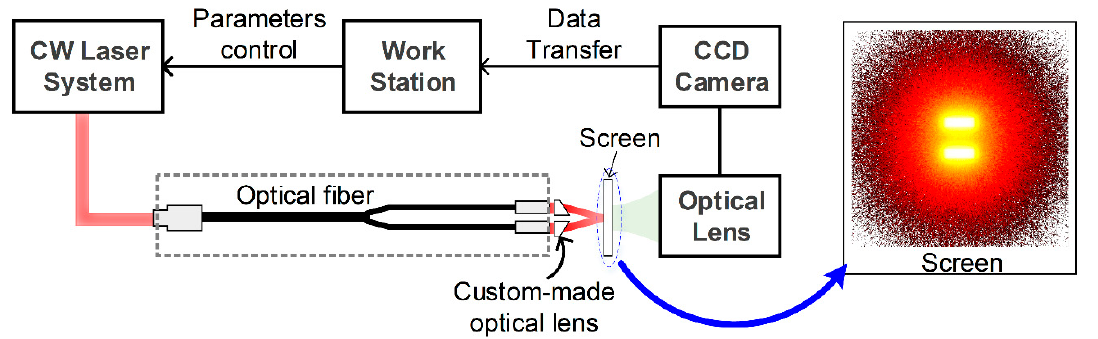
Figure 6. Illustration of the experimental setup for light-intensity distribution measurement as a function of depth. CW, continuous wave; CCD, charge-coupled device.